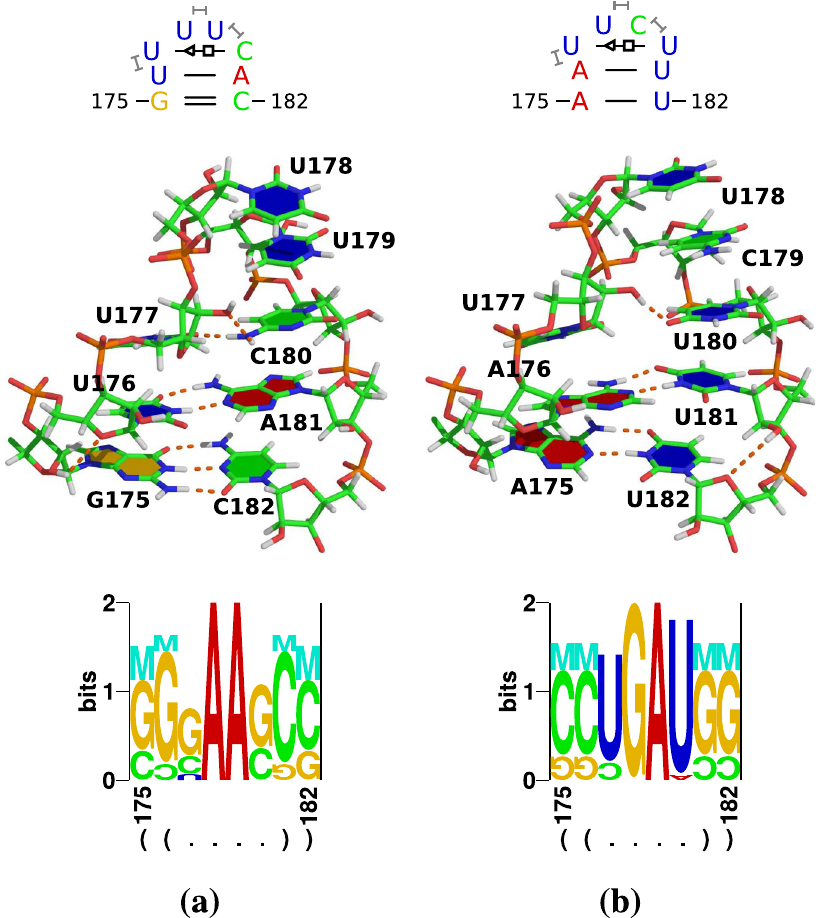
Figure 5. Results of Rosetta modelling of HP loop. Results for a typical loop of most pospiviroids is shown in ( a ); an exceptional loop of TCDVd is shown in ( b ). Top: Interactions identified by rnaview and x3dna-dssr. Middle: 3D view produced by PyMOL. Bottom: Logos produced by